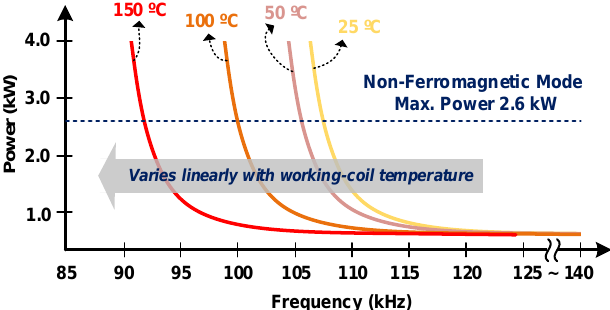
Figure 13. Variation in IH power curve owing to rising working-coil temperature.